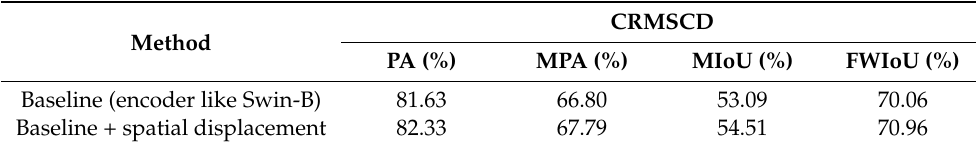
Table 9. Ablation experiments of spatial displacement on encoder.